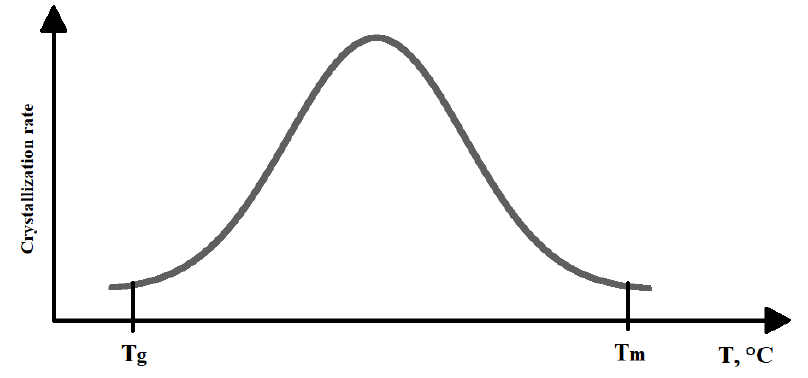
Figure 5. Temperature dependence of the crystallization rate (a theoretical curve).